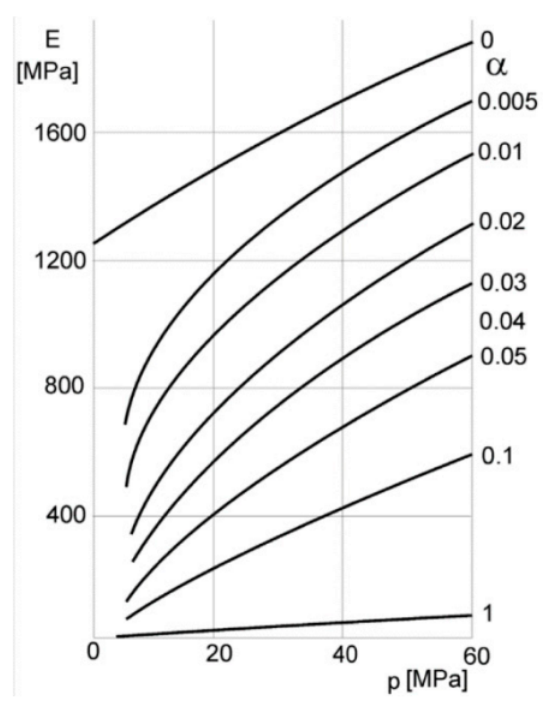
Figure 2. Dependence of the modulus of elasticity E of the air–fuel oil mixture on the pressure p and relative volume of air α